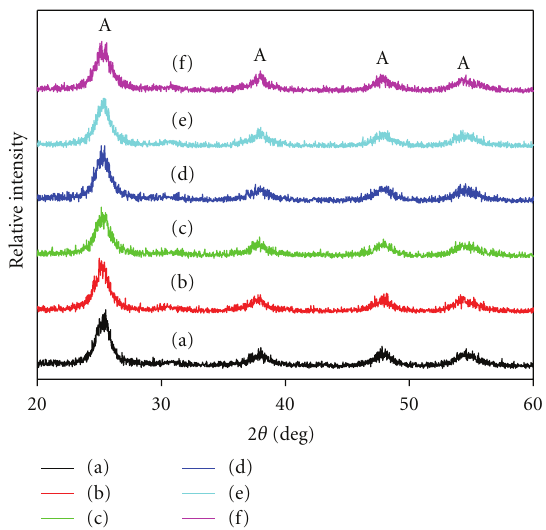
Figure 1: XRD patterns of the Au-TiO 2 composite powders pre- pared with di ff erent R Au : (a) 0, (b) 0.003, (c) 0.006, (d) 0.015, (e) 0.030, and (f)